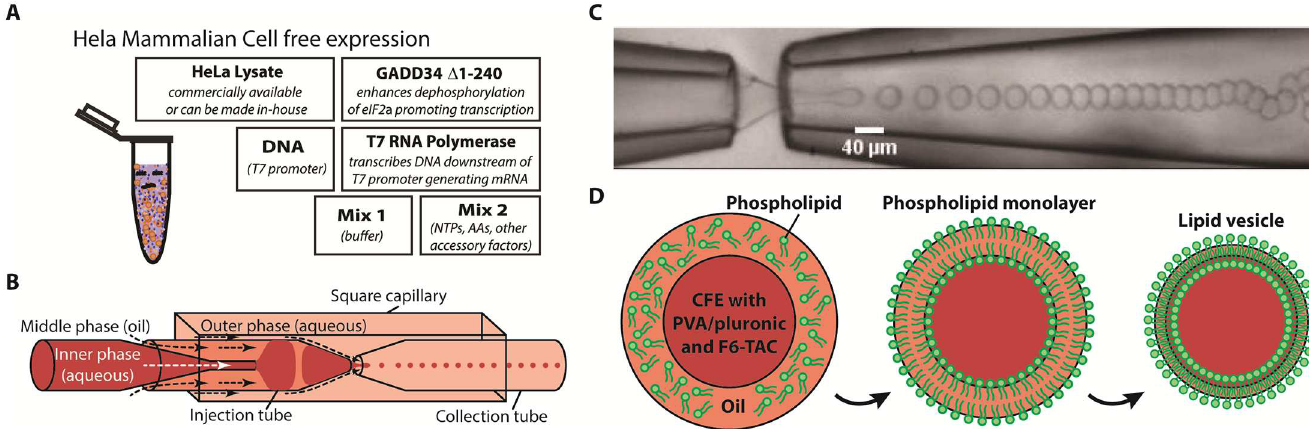
Fig 1. Encapsulation of Cell-Free Expression (CFE) and formation of lipid vesicles. (A) HeLa mammalianCFE system is a combination of HeLa lysate, Mix 1 buffer, GADD34,T7 RNA polymerase, Mix 2 accessory factors and DNA plasmidcontainingT7 promoter. (B) Thin doubleemulsionsare formed in the glass capillarymicrofluidic device. (C) Image of thin doubleemulsionformation using the glass capillarymicrofluidicdevice. (D) Lipid vesicles are formed by first forming aqueous-in-oil-in-aqueous doubleemulsionswhere phospholipids are dissolvedin volatile middlephase organicsolvents. CFE system was encapsulated with surfactant (PVA/pluronic) and fluorinatedsurfactant (F6-TAC/F8-TAC) inside the lipid vesicles. Phospholipids self- assemble to form phospholipid monolayers on the aqueous-oil and oil-aqueous interfaces. Upon solvent evaporation,lipid vesicles form.